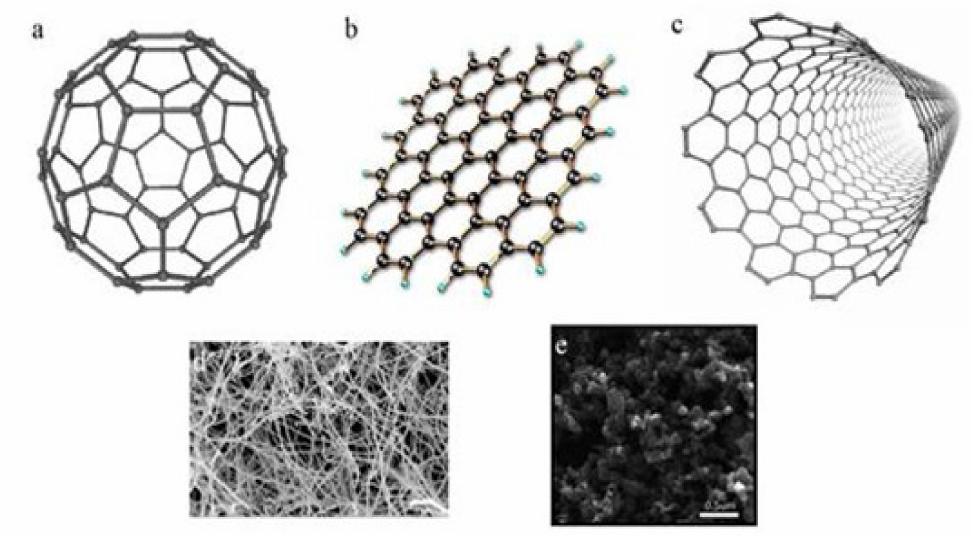
Figure 2. Structures of carbon-based NPs ( a ) fullerenes, ( b ) graphene, ( c ) carbon nanotubes, ( d ) carbon nanofibers, and ( e ) carbon